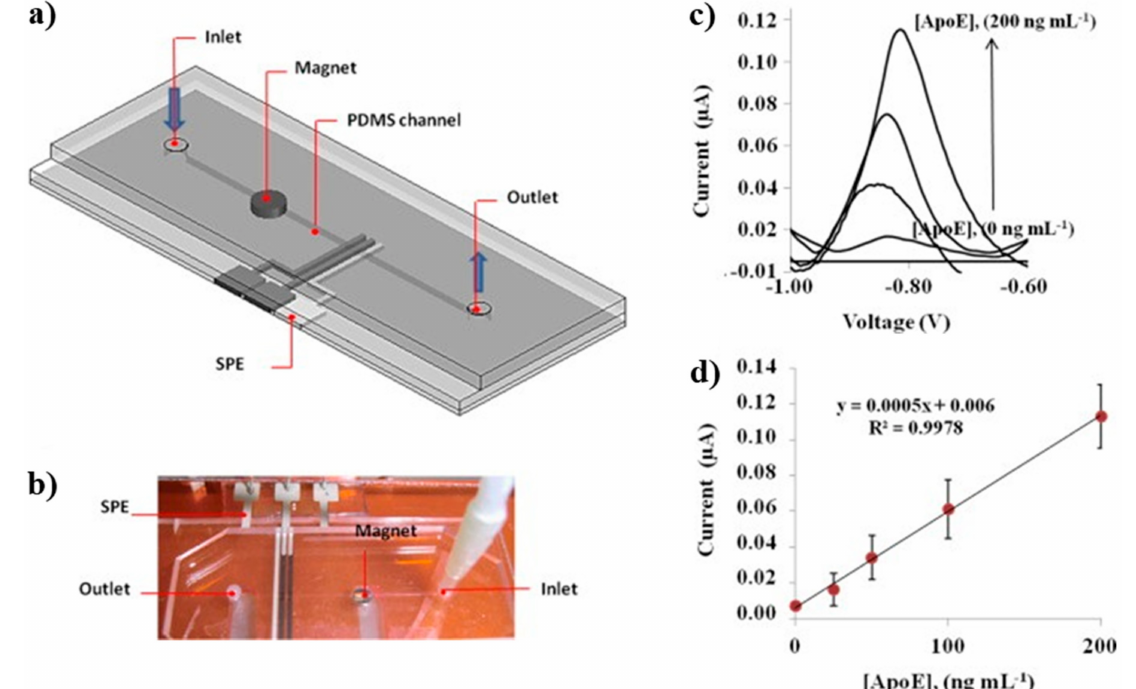
Figure 8. ( a ) Schematics of the electrochemical immunosensing system for ApoE detection. ( b ) Microfluidic platform integrated with screen–printed electrodes, and the picture of actual the set–up. ( c ) Square wave voltammograms of the ApoE–immunoassay in the presence of different concentrations of ApoE (0–200 ng/mL) using QDs as electrochemical labels (Electrochemical conditions; − 1.1 V of deposition potential for 120 s; stripping between − 1.1– − 0.15 V; V scan rate = 10 mV/s; Frequency = 25 Hz; and flow rate = 5 µ L/min). ( d ) The calibration plot for the standard sample of ApoE. Reproduced with permission from [48]. Copyright © 2020 Elsevier